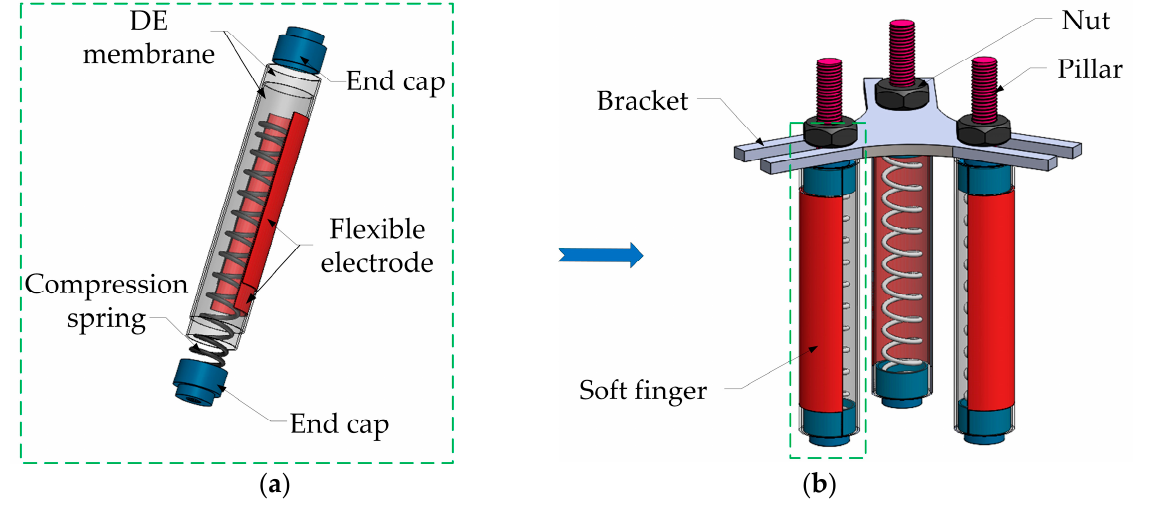
Figure 1. ( a ) Schematic diagram of the soft gripper. ( b ) Schematic diagram of the soft fingers.